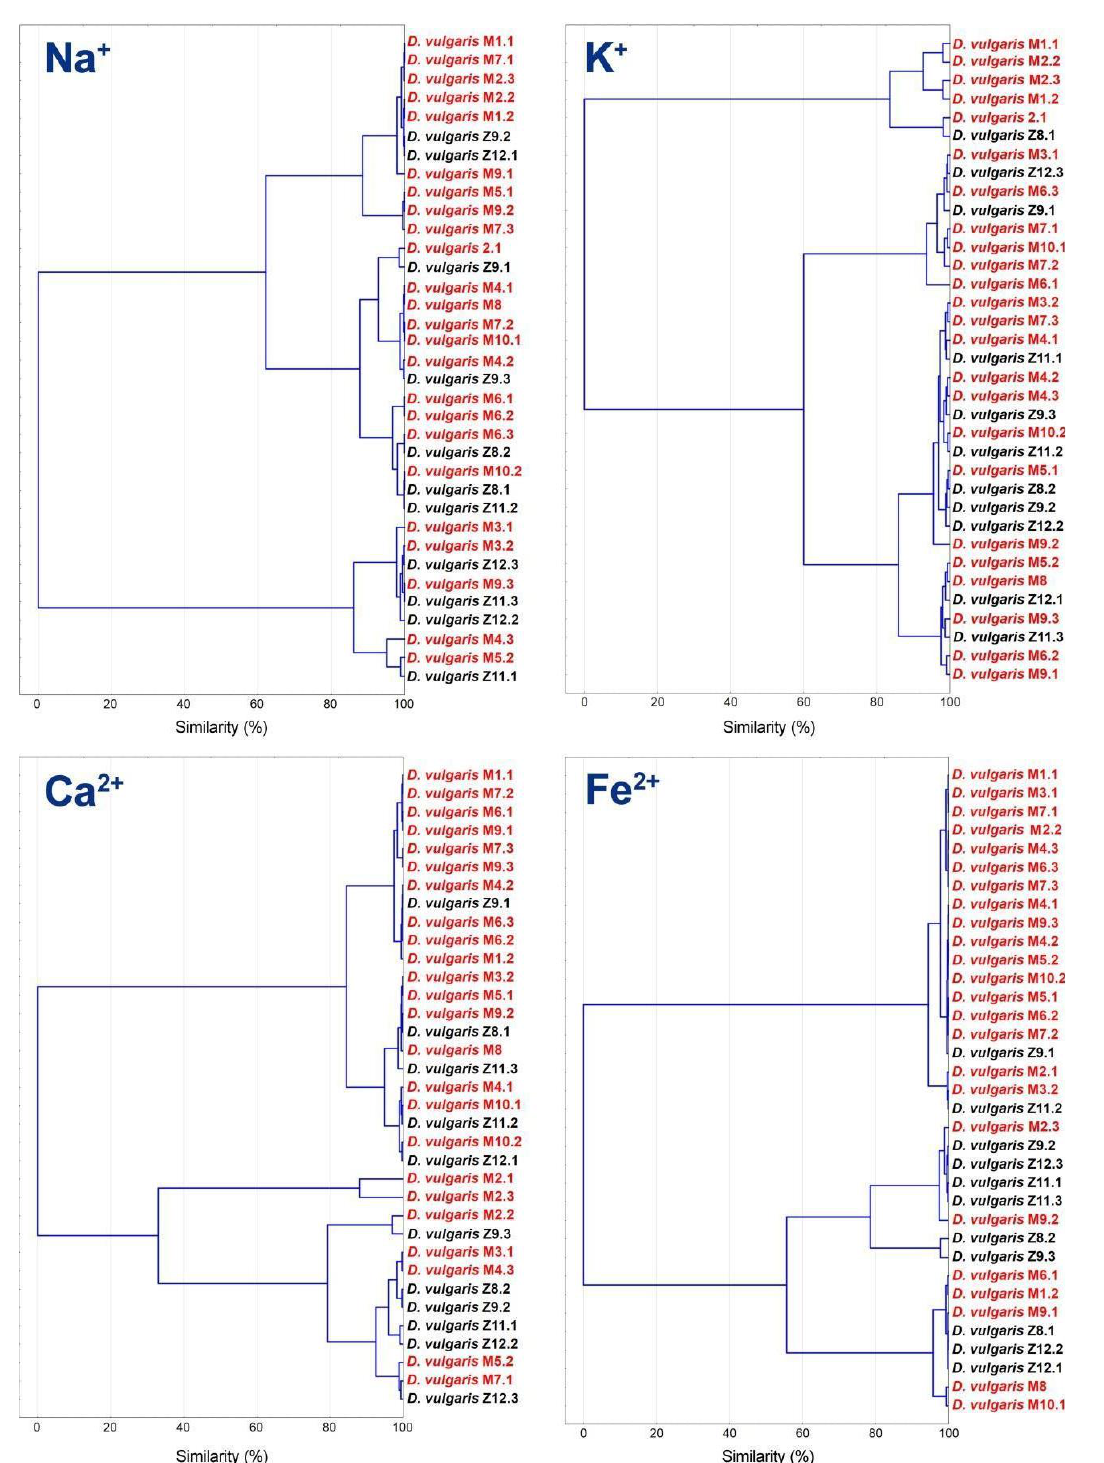
Figure 6. Cluster analysis based on concentrations data of physiological important elements (Na + , K + , Ca 2+ and Fe 2+ ).